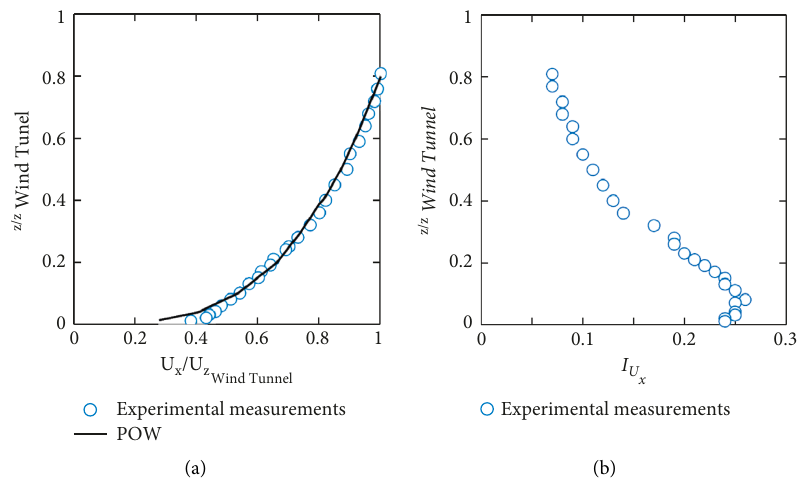
Figure 6: Longitudinal wind profiles: (a) mean wind speed; (b) turbulence intensity.